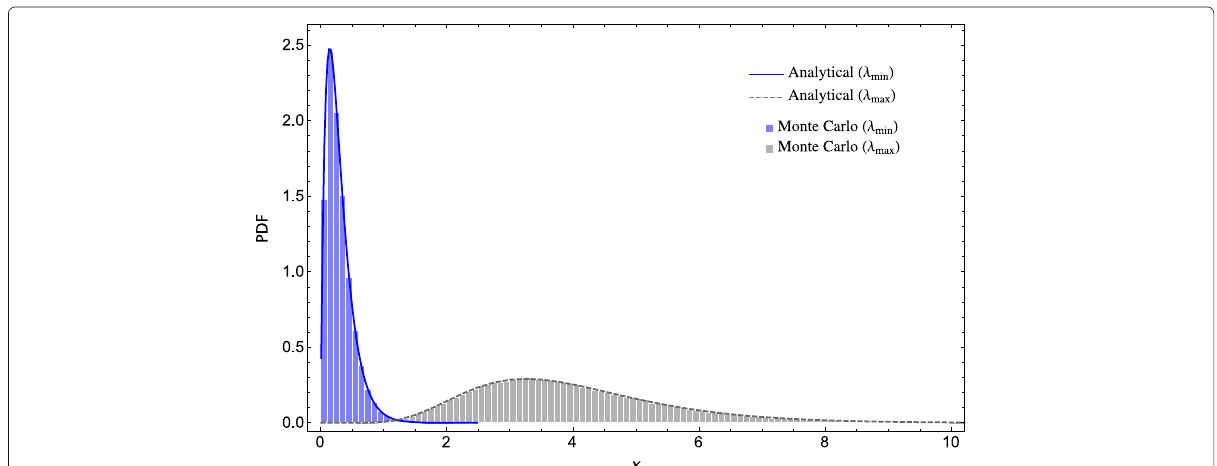
Fig. 4 PDF of the smallest eigenvalue ( λ min ) and that of the largest eigenvalue ( λ max ), as given by (26) and (28). The parameter values are n = 3, n A = 4, n B = 5, and b = 1 /